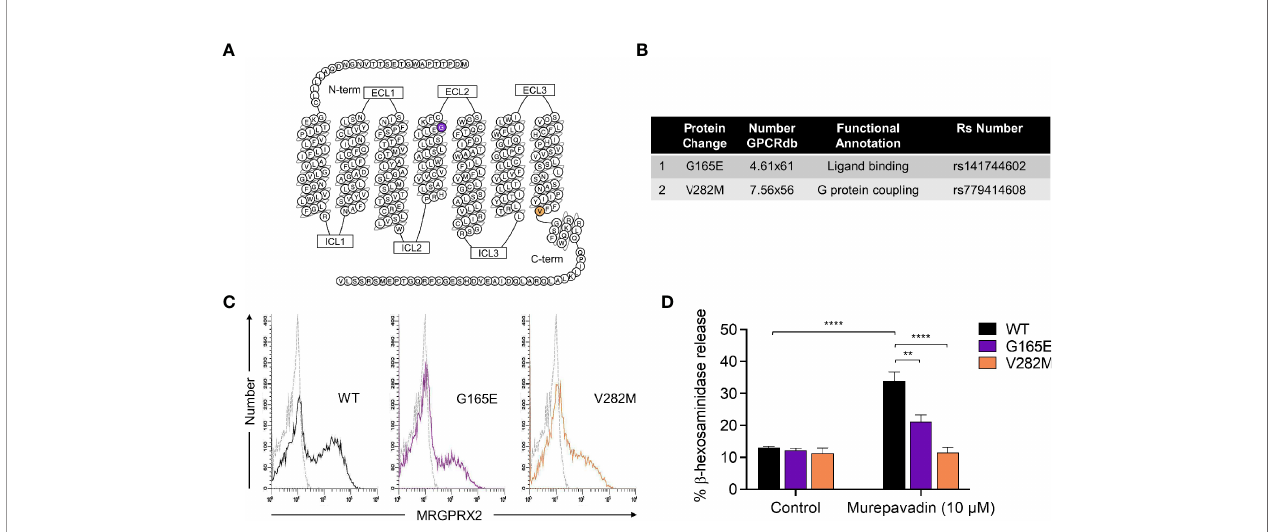
FIGURE 3 | Naturally occurring MRGPRX2 missense variants are hypo-responsive to murepavadin for MC degranulation. (A) Snake diagram of MRGPRX2 indicating the two amino acid residues to be investigated. (B) Single amino acid substitution for each of the MRGPRX2 variant is shown in the table. (C) Cell surface receptor expression of the wild-type MRGPRX2 (WT) and its missense variants (G165E and V282M) was con fi rmed using fl ow cytometry. (D) RBL cells expressing MRGPRX2 (WT) and its variants (G165E and V282M) were exposed to 10 m M murepavadin (30 min) and degranulation was assayed by measuring the release